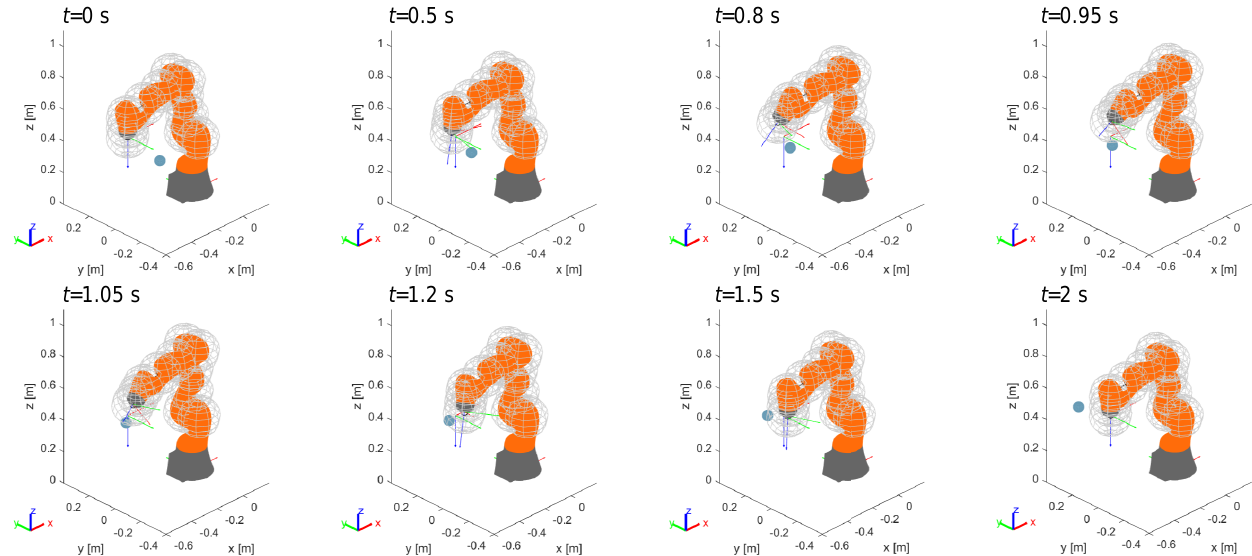
Figure 9. Example 1: avoidance of a dynamic obstacle interfering with the end-effector in a fixed